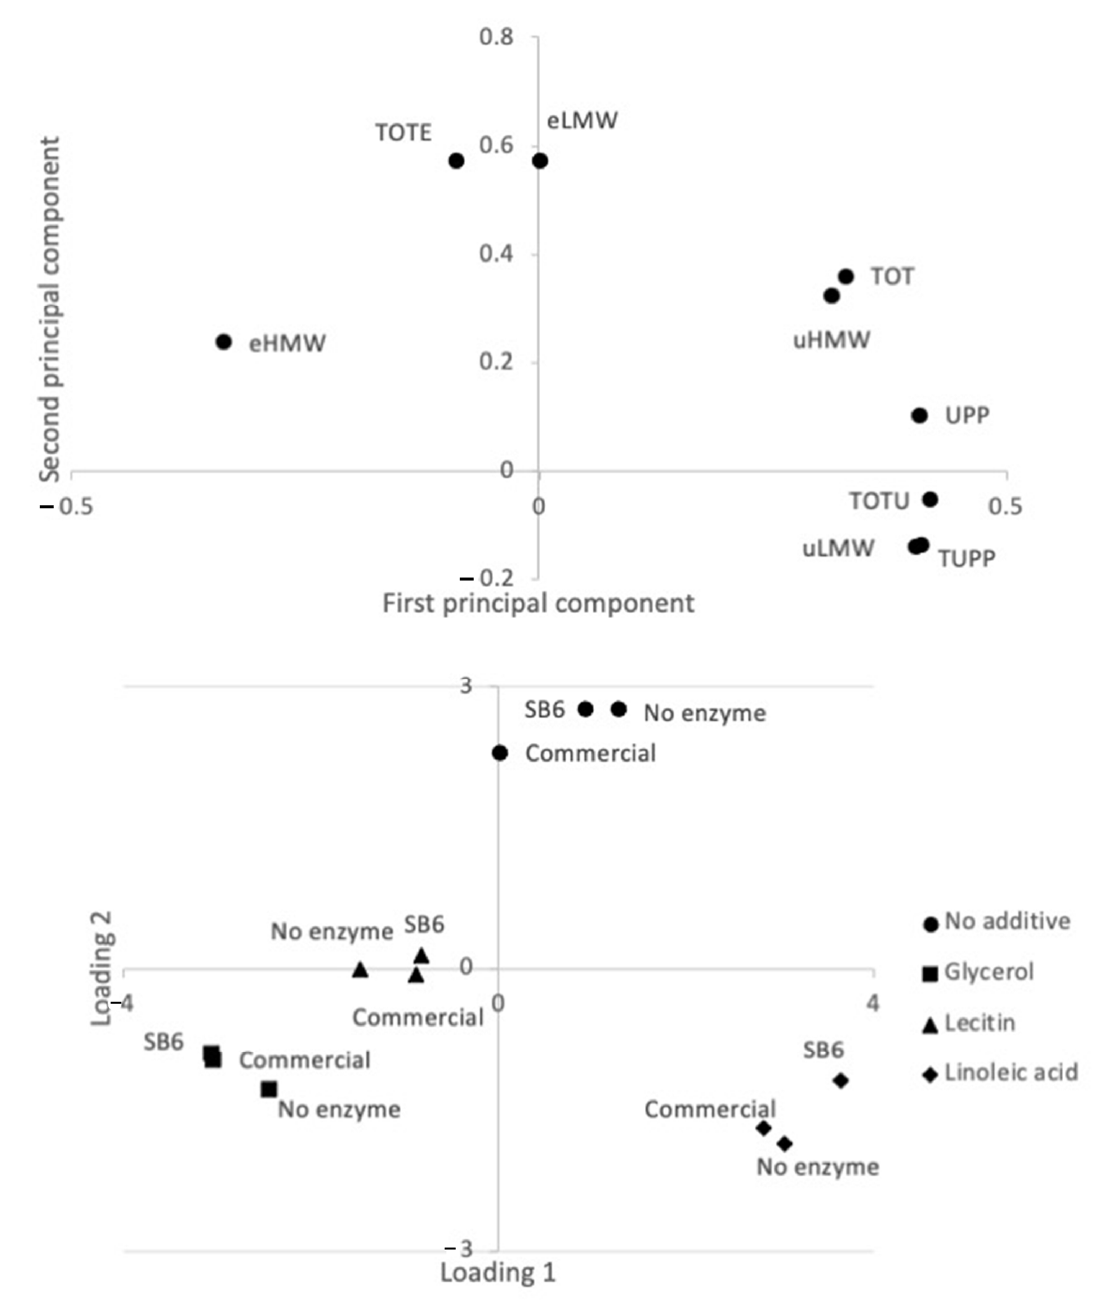
Figure 2. Score ( A ) and loading plot ( B ) from principal component analysis (PCA) of lupin foams: eHMW: SDS-extractable high molecular weight proteins; eLMW: SDS-extractable low molecular weight proteins; uHMW: SDS-unextractable high molecular weight proteins; uLMW: SDS-unextractable low molecular weight proteins; UPP: percentage of unextractable polymeric protein in total polymeric protein; TUPP: percentage of total unextractable protein; TOT: total protein; TOTU: total unextractable protein.